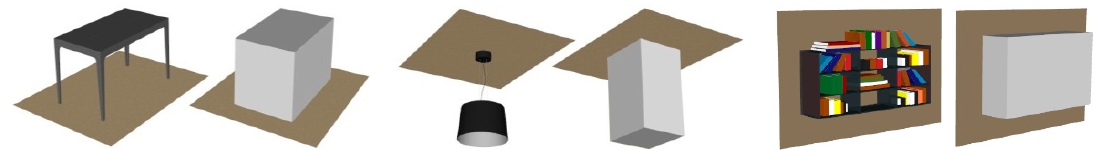
Figure 6. The aligned axis bounding box (AABB) simplified representation of furniture.